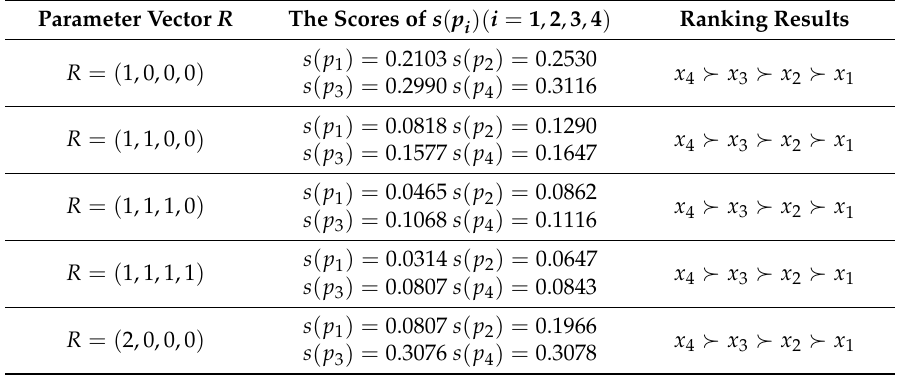
Table 4. Ranking results by utilizing the different parameter vector R in the PFIWDMM